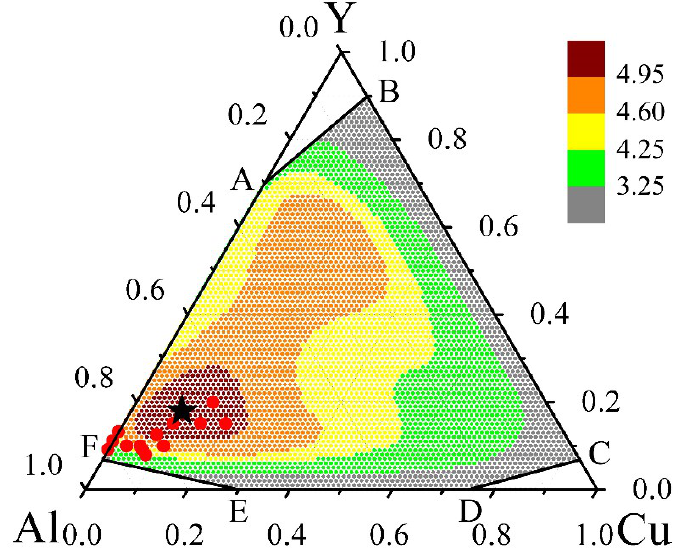
Figure 2. Contour map of the parameter γ*, an indicator of GFA that evaluates both the driving force of the amorphous phase and its resistance to crystallization, derived from the thermodynamic calculations for the ternary Al-Cu-Y system. The black asterisk pinpoints the stoichiometry of Al 72 Cu 10 Y 18 with the largest γ*. The red dots denote the experimentally observed compositions of glass formation in the Al-rich corner that are reported in the